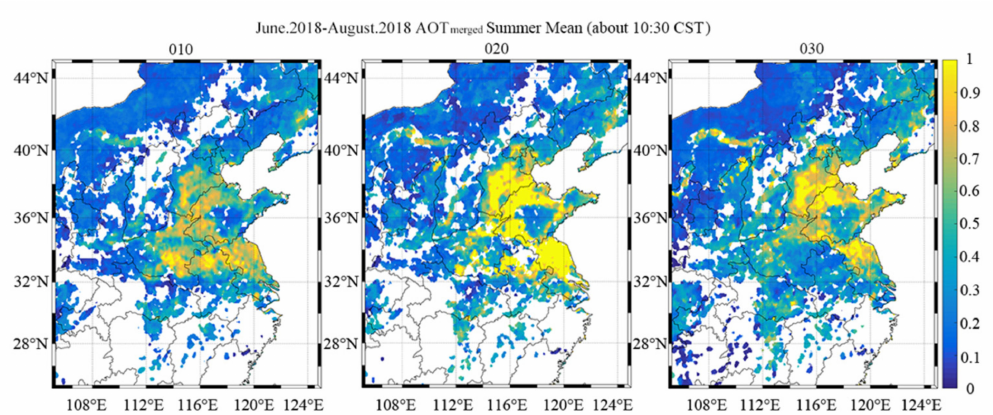
Figure 9. The AOT merged 5km summer mean spatial distribution of three versions at about 10:30 a.m. CST. ( a ) version 010; ( b ) version 020; ( c ) version